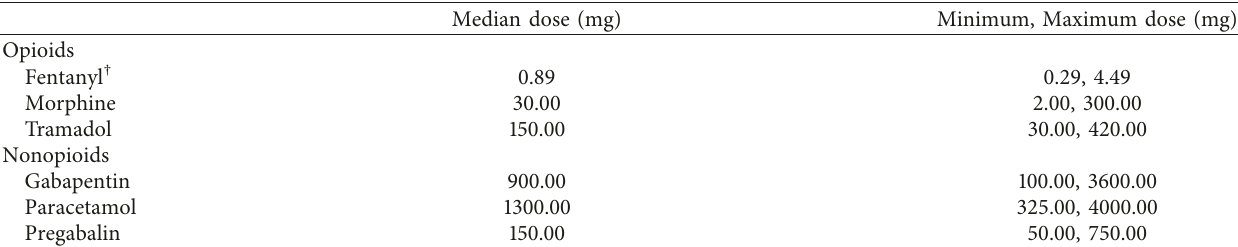
Table 3: Total daily dose of analgesics prescribed.